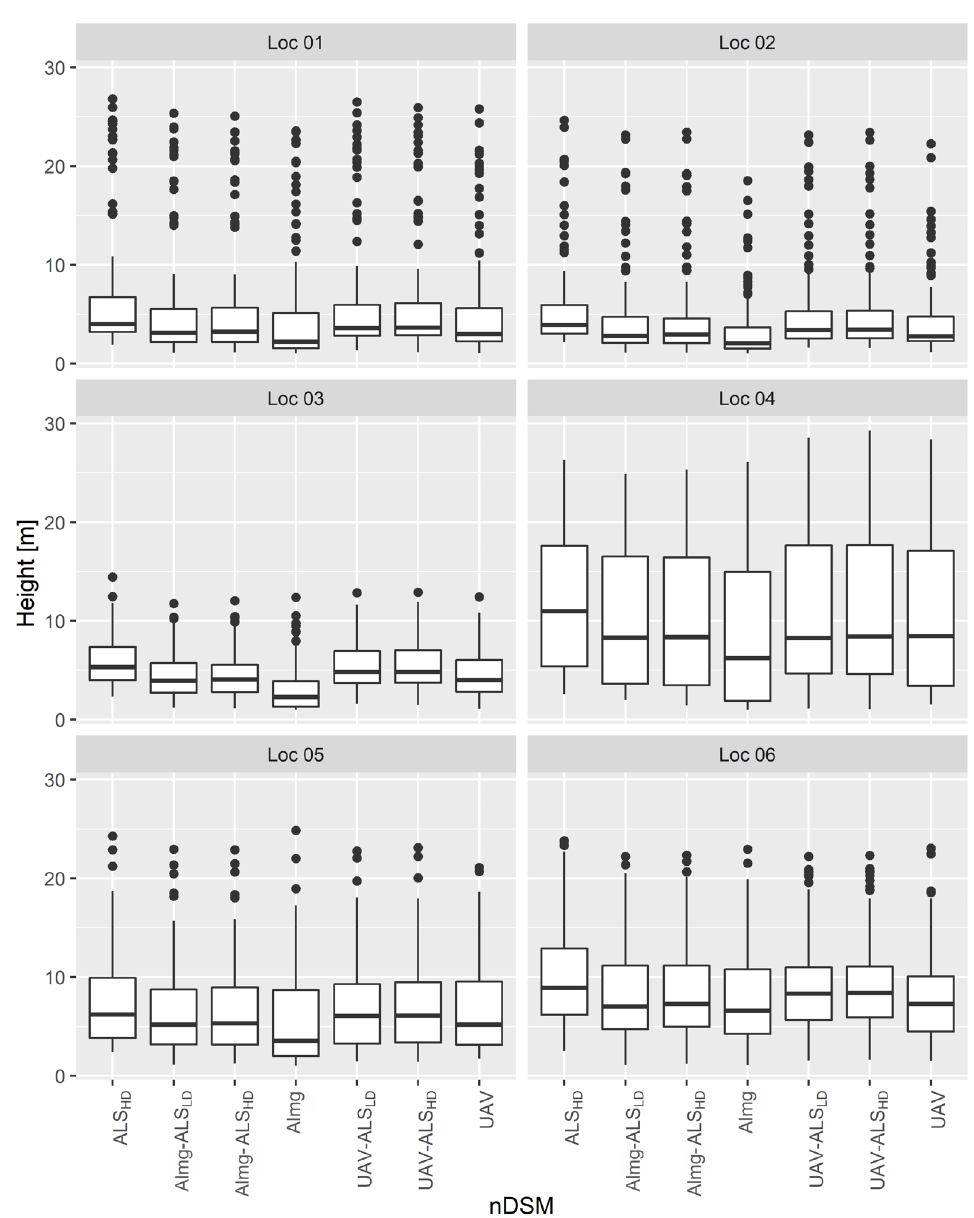
Figure A1. Box-plots displaying quartile characteristics (median, Q25, and Q75) of the absolute nDSM heights for each study location. For each location, 100 randomly selected woody plant tops were used. Black dots represent outliers.